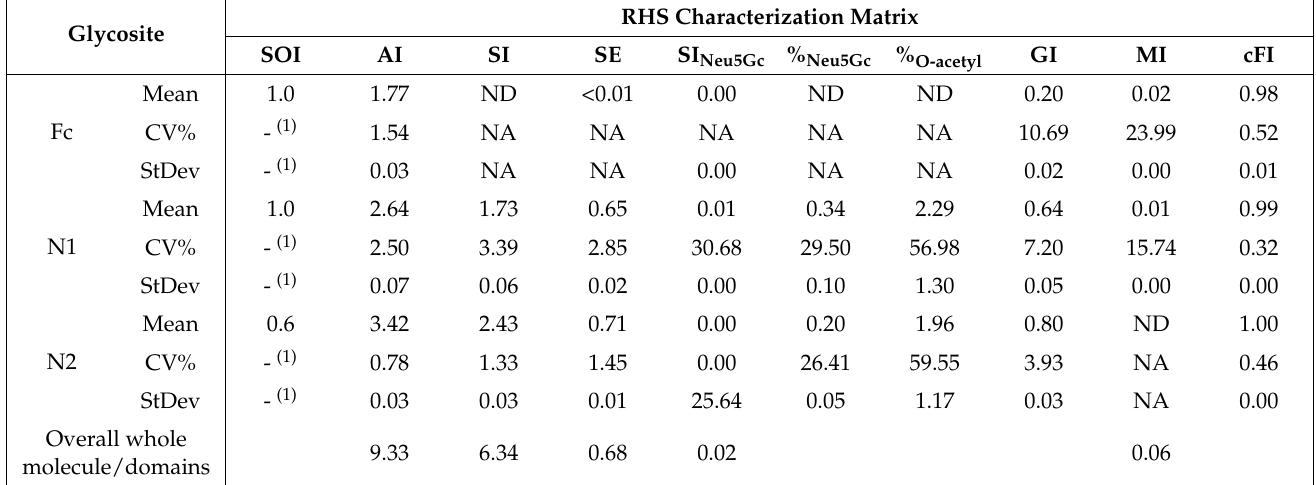
Table 4. RHS glycan characterization